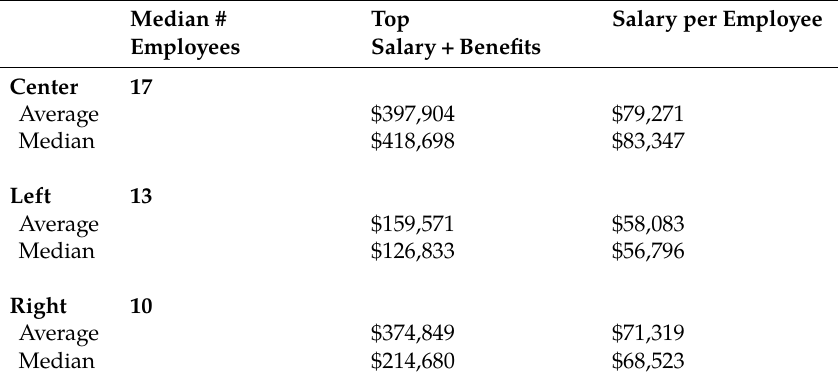
Table 5: Public support percentage,